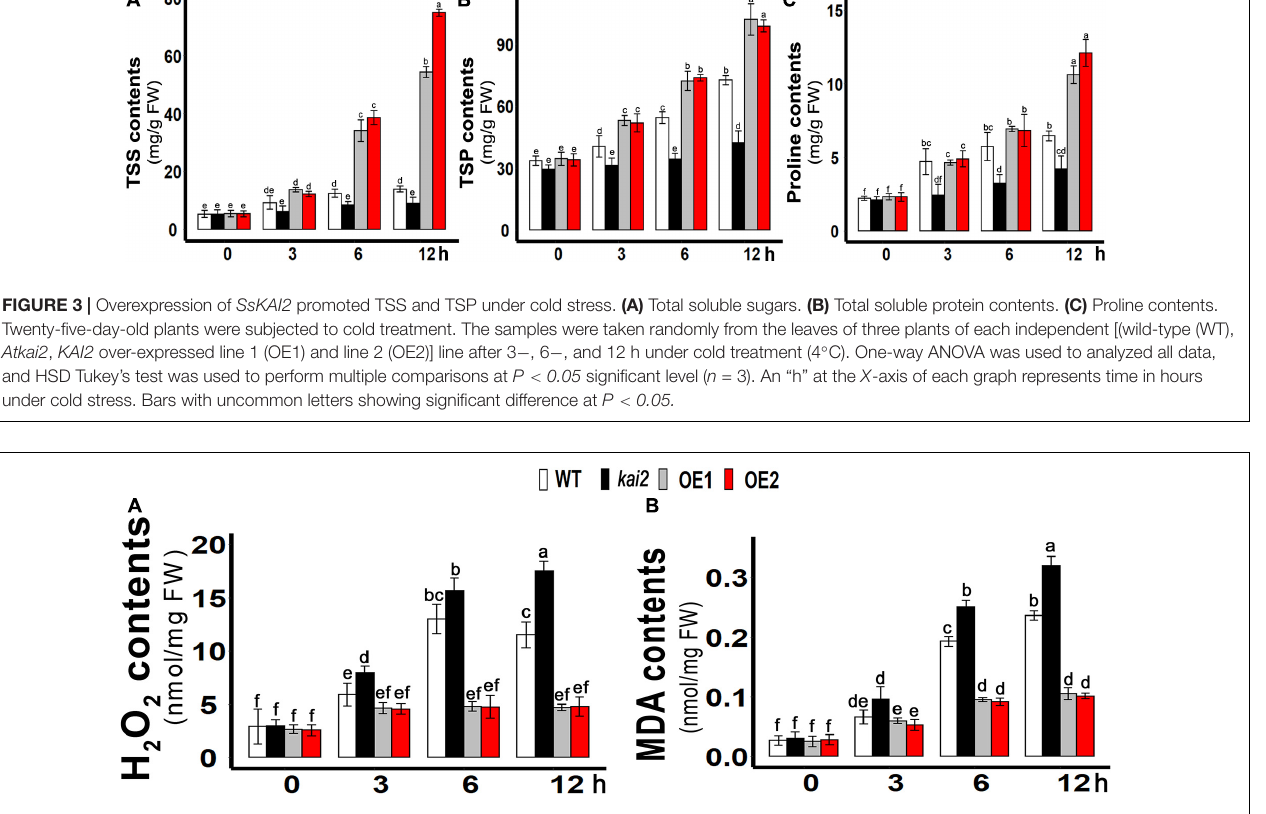
FIGURE 4 | Overexpression of KAI2 in Arabidopsis reduced H 2 O 2 and MDA levels under cold stress. (A) H 2 O 2 contents. (B) MDA contents. The samples were taken randomly from the leaves of three plants of each independent (WT, Atkai2 , OE1, and OE2) line after 0 − , 3 − , 6 − , and 12 h under cold treatment (4 ◦ C). One-way ANOVA was used to analyzed all data, and HSD Tukey’s test was used to perform multiple comparisons at P < 0.05 significant level ( n = 3). Bars with uncommon letters showing significant difference at P < 0.05. An “h” at the X -axis of each graph represents time in hours under cold